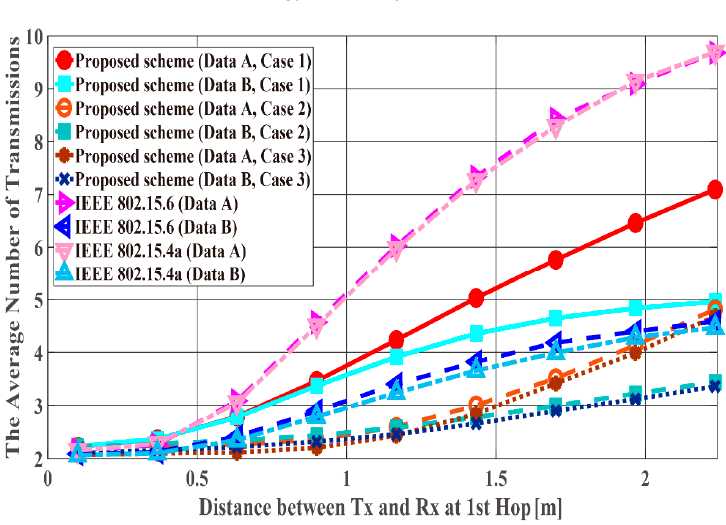
Figure 13. Average number of transmissions with constant (cid:1856) (cid:2870)(cid:3041)(cid:3031) .